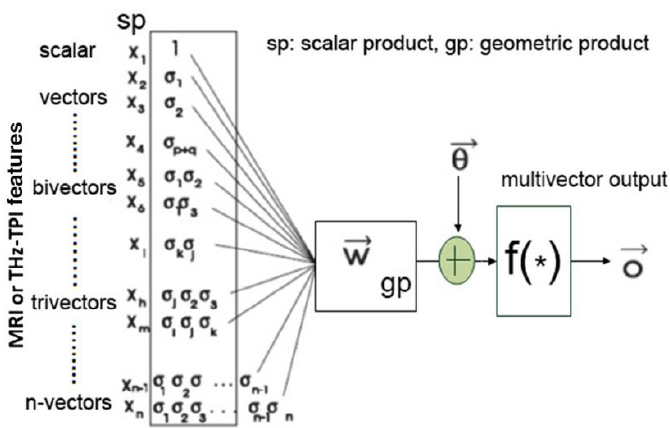
Figure 5. Geometric neuron based on the McCulloch-Pitts neuron for magnetic resonance imaging (MRI) and terahertz (THz) pulse imaging datasets based on the generic framework discussed in Ref. [57].